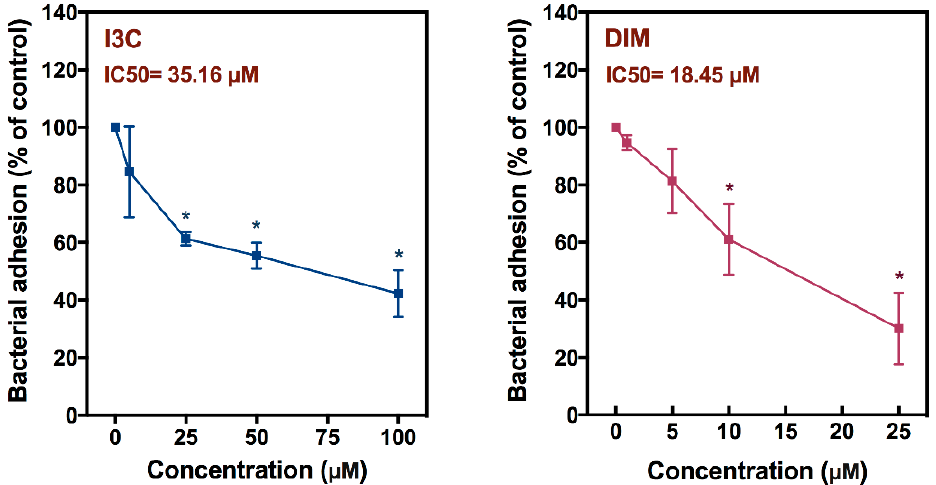
Figure 7. Effects of I3C and 3,3 ′ -diindolylmethane (DIM) on adhesion of Cr to Caco-2 cell in vitro. Caco-2 cells were seeded in 24-well plates for 2 days and then co-cultured with the bacteria in the presence of I3C or DIM for 1 h. After incubation, the bacteria adherent to the cells were counted as described in the Materials and Methods section. Results expressed as mean+/-SD ( n = 4) are shown as the percentage of Cr attachment relative to control cultures. * indicates significantly different from control ( p < 0.05).